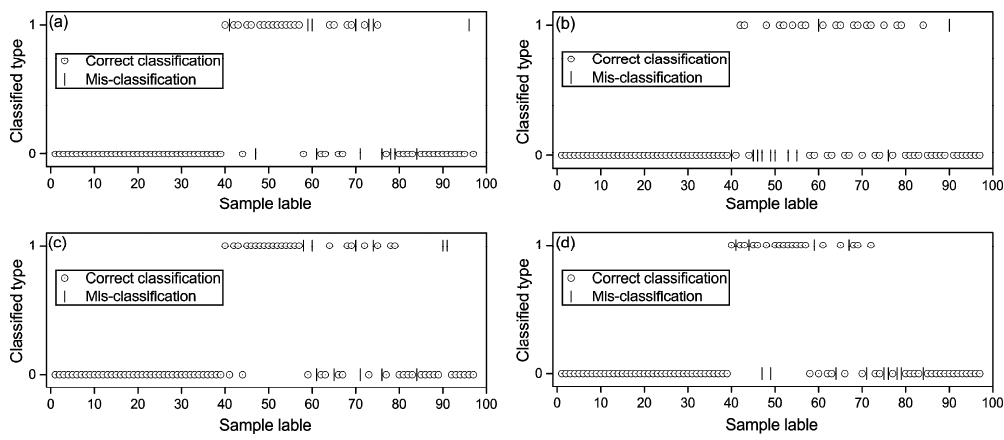
Figure 4. Mean decrease GINI values for RELIEF-selected spectral features.